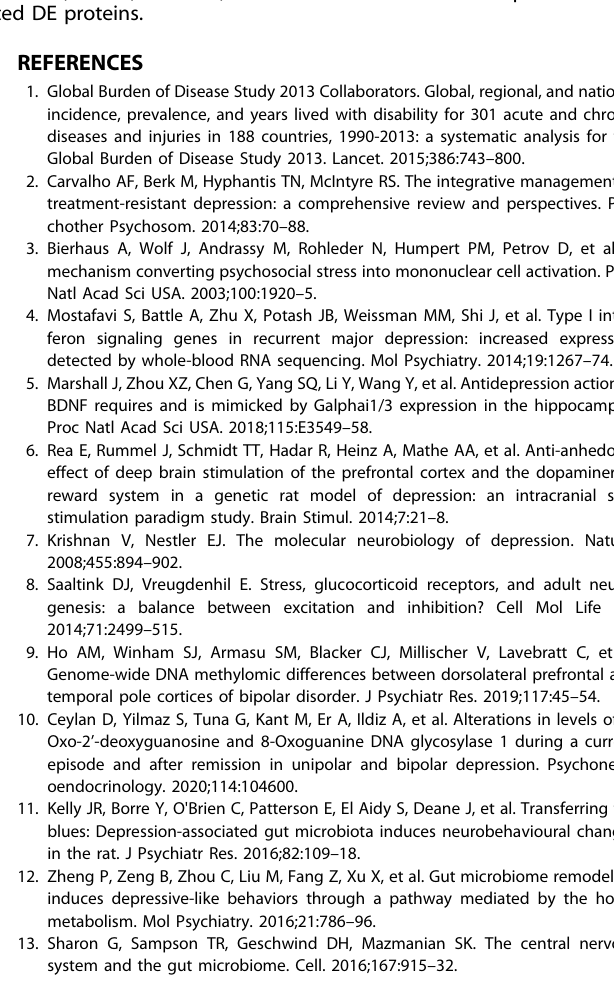
Fig. 4 The PPI networks of the gut – brain axis. The PPI network of the A PFC, B liver, C cecum, and D serum based on the DE proteins. Blue dots indicate downregulated DE proteins. Red dots indicate upregulated DE